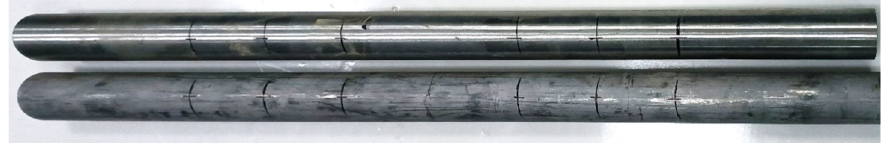
Figure 2. The 304 stainless steel pipes used in the test. The wall thickness is 0.1 mm and 0.2 mm from top to bottom respectively. Table 1. Grouping design table of test scheme.